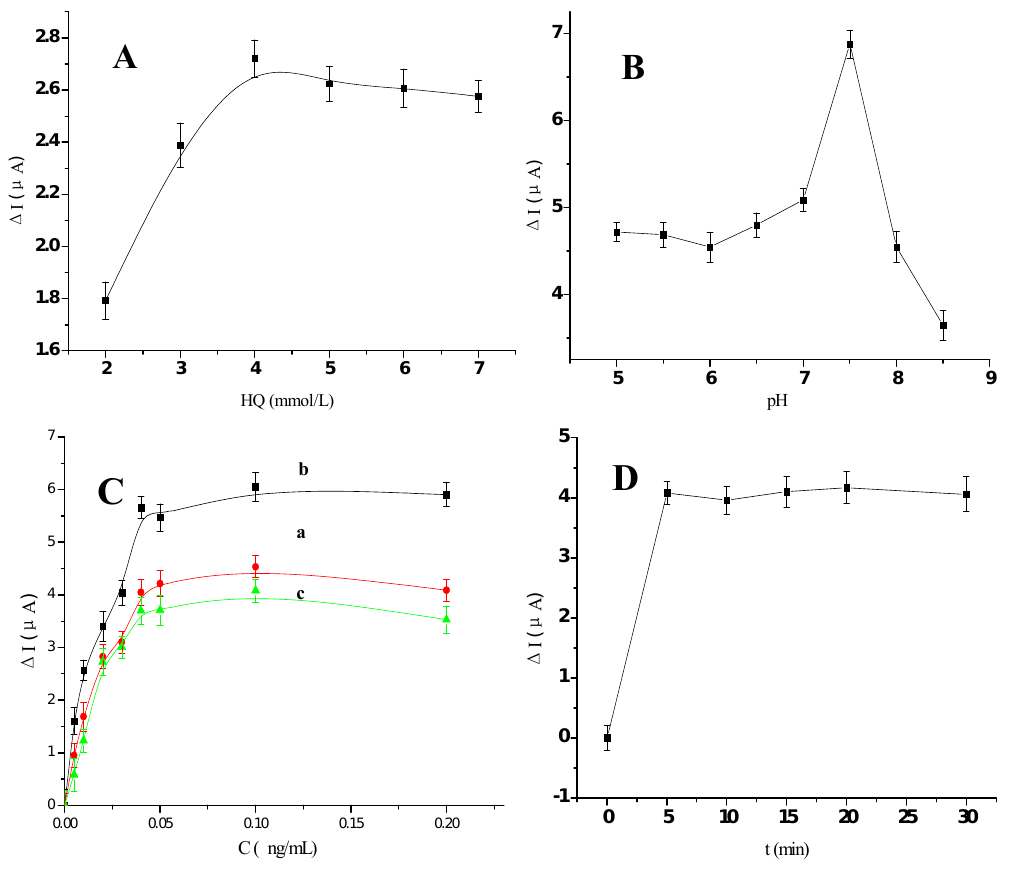
Figure 6. ( A ) The effect of the different concentration of HQ from 2 mmol/L to 7 mmol/L; ( B ) The pH dependency of the anodic peak currents responses for the immunosensor; ( C ) The effect of the different volume ratio of EVC and AFP Ab2 ( a ) 0.1:1, ( b ) 1:1 and ( c ) 100:1 ([AFP Ab2] = 50 μ g/mL); ( D ) The effect of the different incubation time of EVC-AFP Ab2 after the immunosensor incubated with 0.2 ng/mL AFP solution. All experiments scan rate 50 mV/s, in 0.01 mol/L PBS/0.1 mol/L KCl (pH 7.4) added 5 mmol/L